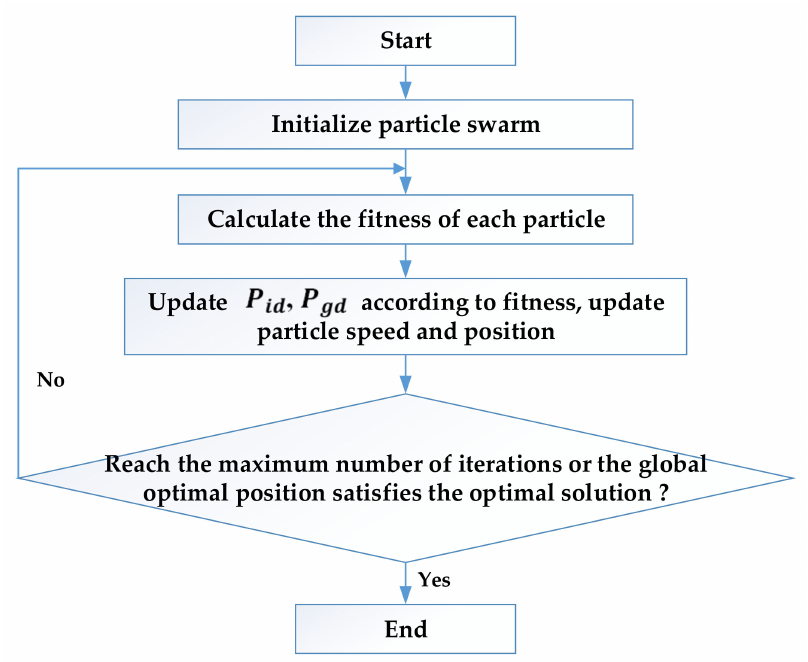
Figure 4. Particle swarm algorithm